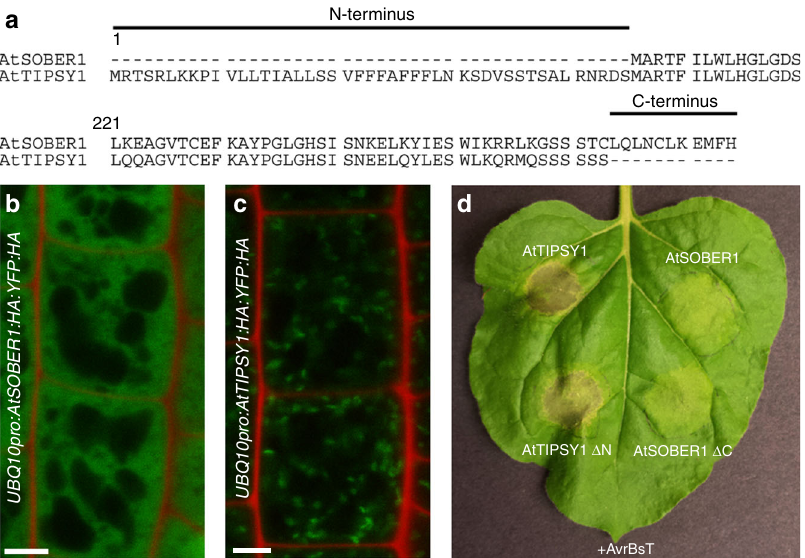
Fig. 4 Suppression of HR is not determined by the protein termini of SOBER1 and TIPSY1. a Terminal sequences of both Arabidopsis proteins. b , c Localization of YFP-tagged AtSOBER1 ( b ) and AtTIPSY1 ( c ) in epidermal root cells of transgenic Arabidopsis seedlings. YFP signals are depicted in green, while propidium iodide, which was used for counterstaining, is shown in red. d Transient co-expression of AtSOBER, AtTIPSY1 and their truncated mutant variants with avrBsT in N. benthamiana . Scale bar = 5 µ